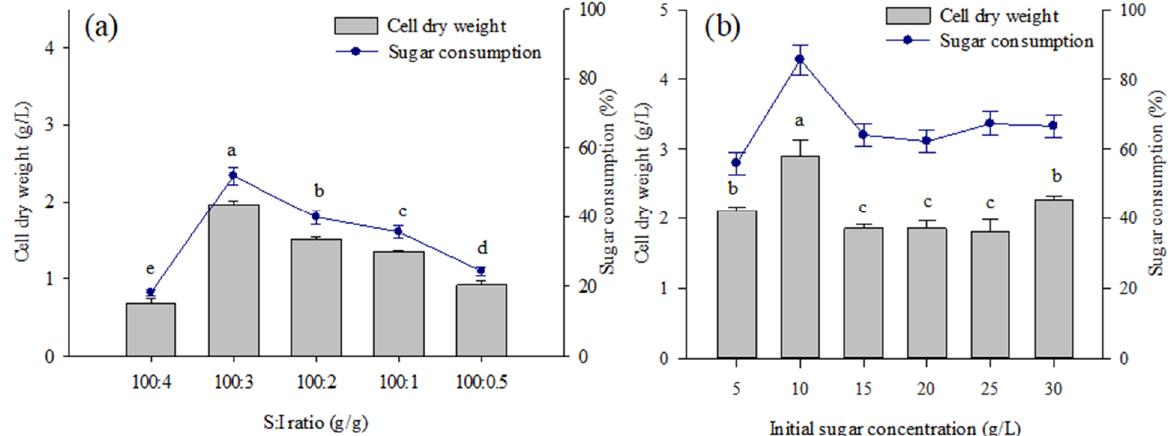
Figure 3. Effect of ( a ) substrate to inoculum (S:I) ratio and ( b ) initial sugar concentration on biomass production and sugar consumption of Coelastrella sp. KKU - P1 cultivated in a molasses-based medium. Different lowercase letters on the top of the bars indicate significant effects of the S:I ratio or initial sugar concentrations on biomass production ( p ≤ 0.05, ANOVA with Duncan’s multiple range test).